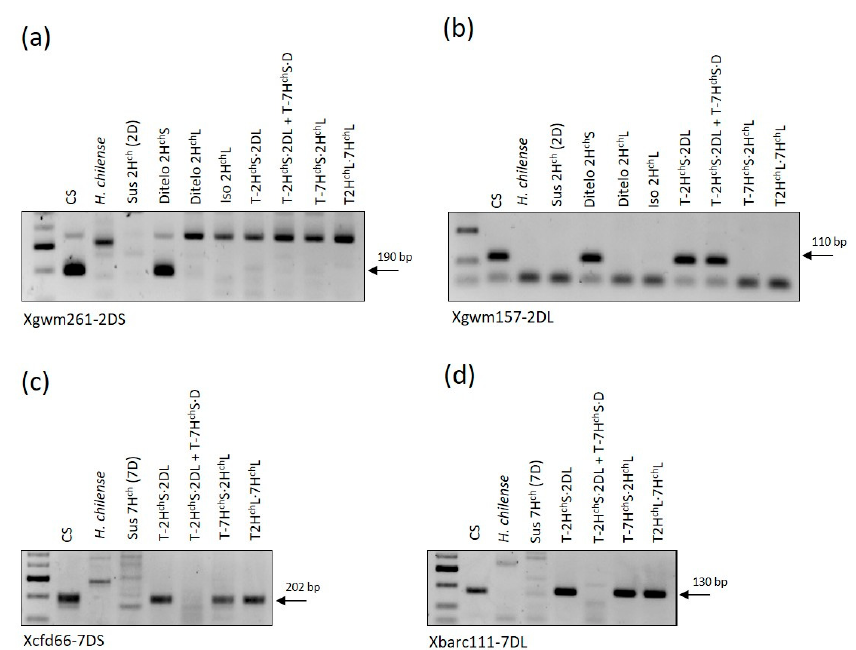
Figure 2. Molecular characterization of introgression lines with wheat chromosome-specific simple sequence repeats (SSR) markers. ( a ) Xgwm261 -2DS; ( b ) Xgwm157 -2DL; ( c ) Xcfd66 -7DS and ( d ) Xbarc111 -7DL.